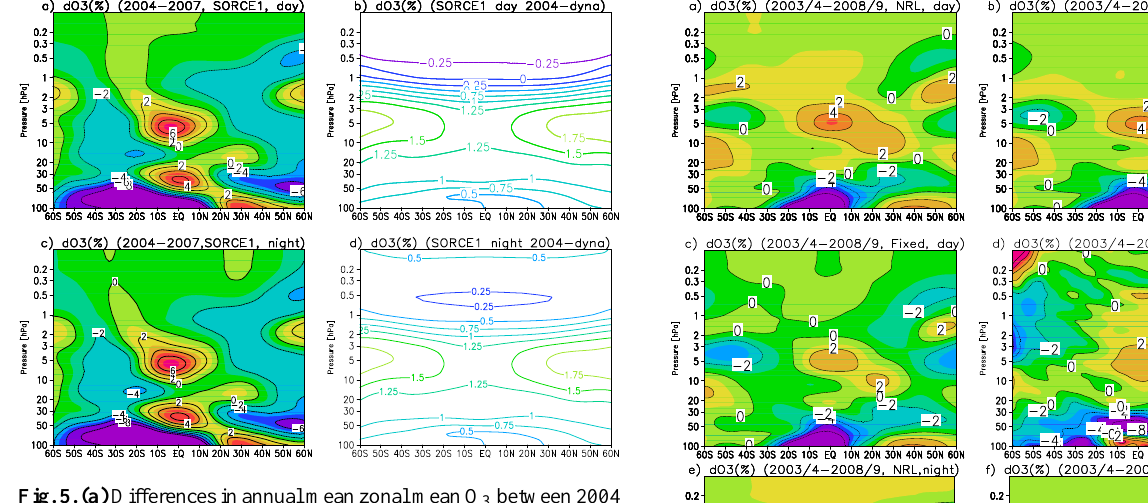
Fig. 5. (a) Differences in annual mean zonal mean O 3 between 2004 and 2007 for D_SORCE2004_1 and E_SORCE2007_1 in daytime (i.e. O 3 change due to both solar flux and dynamical variability). (b) Similar to (a) but for fixed meteorological forcing (year 2004, i.e. O 3 changes only due to solar flux variability). (c) and (d) are similar to (a) and (b) , respectively but for night-time O 3 .